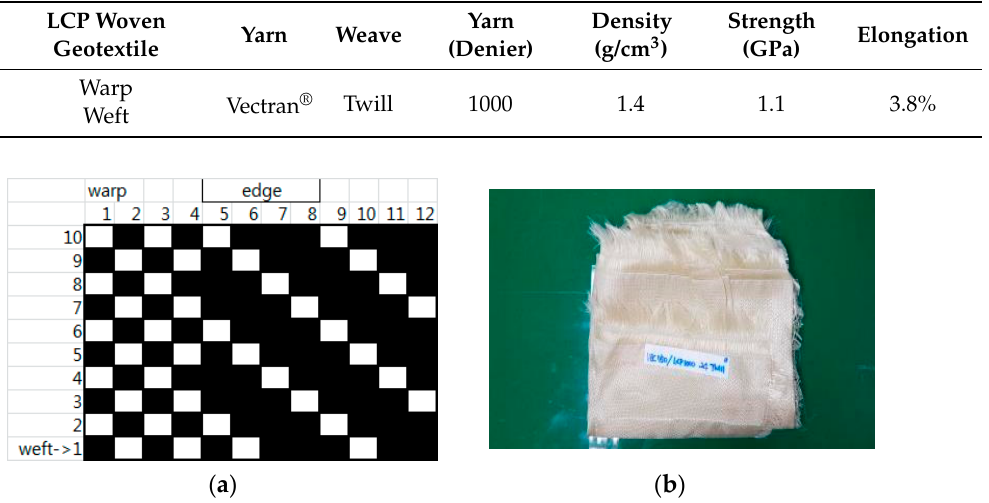
Figure 1. Fabric design diagram and photograph of geotextile. ( a ) Fabric design diagram; ( b ) LCP woven geotextile. woven